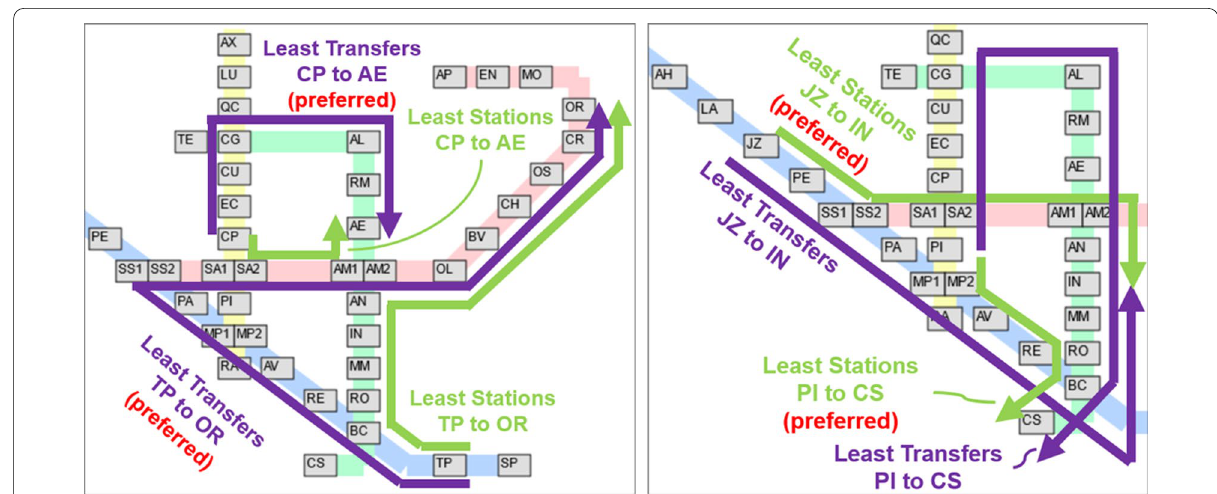
Fig. 13 Visualizations of examples (b) and (c) where the route with least transfers is preferred (left) and examples (e) and (g) where the route with least stations is preferred (right)